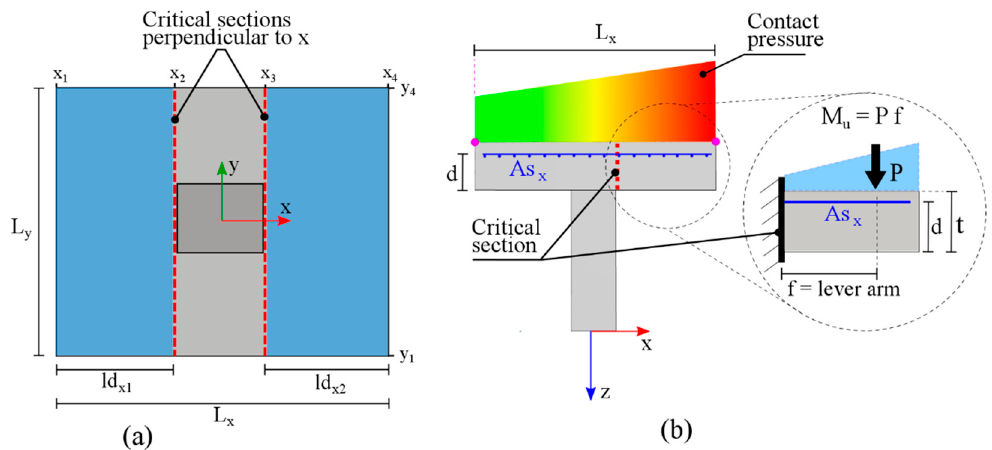
Figure 5. Critical sections perpendicular to x for flexural resistance: ( a ) plan view; ( b ) elevation view. Notice that only the critical sections and bending moments perpendicular to the x direction are shown in Equations (21), (22) and Figure 5. Similarly, the critical sections perpendicular to y should also be checked. The demand–capacity ratio ( d / c ) 3 will be taken as the maximum of the four analyzed critical